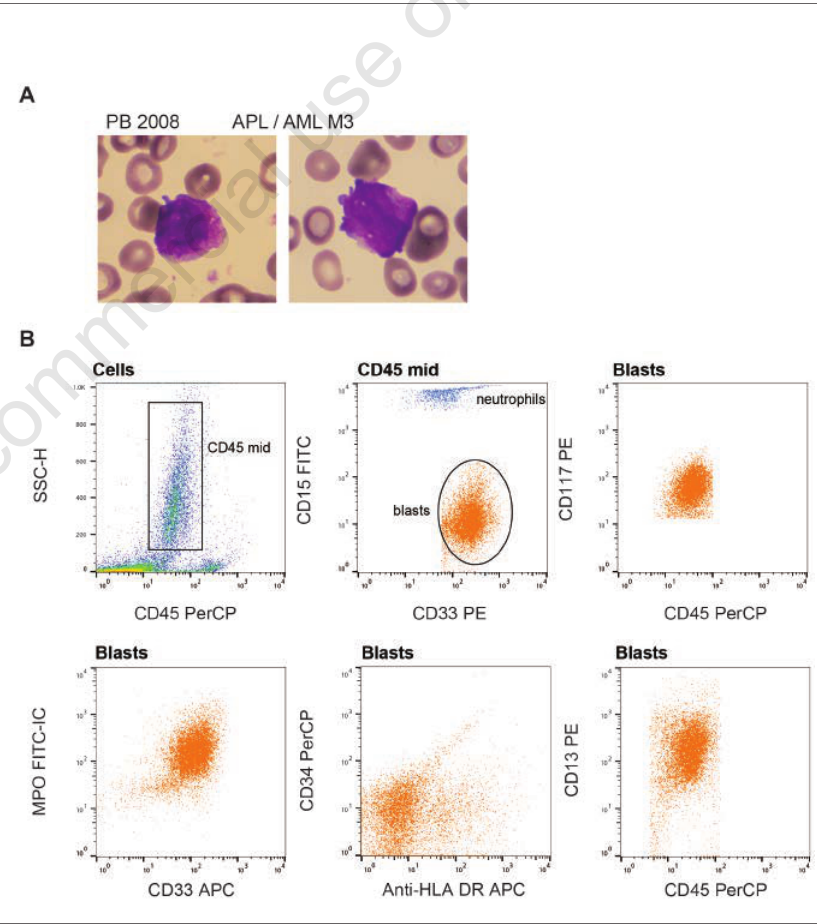
Figure 2. A) Representative pictures of peripheral blood (PB) smear at time of APL (AML M3) diagnosis (Hematoxylin & Eosin staining, magnification ×100). B) Flow cytometry analysis of bone marrow aspirate at time of APL diagnosis. Dot plots are depicted: the gated population is indicated on top of each dot plot. The CD45 mid population was plot- ted against CD15 and CD33, and CD33+CD15- aberrant blasts (orange population in the dot plots) were further analyzed for expression of a series of markers, i.e. surface CD117, CD34, HLA-DR, CD13 and intracellular (IC)